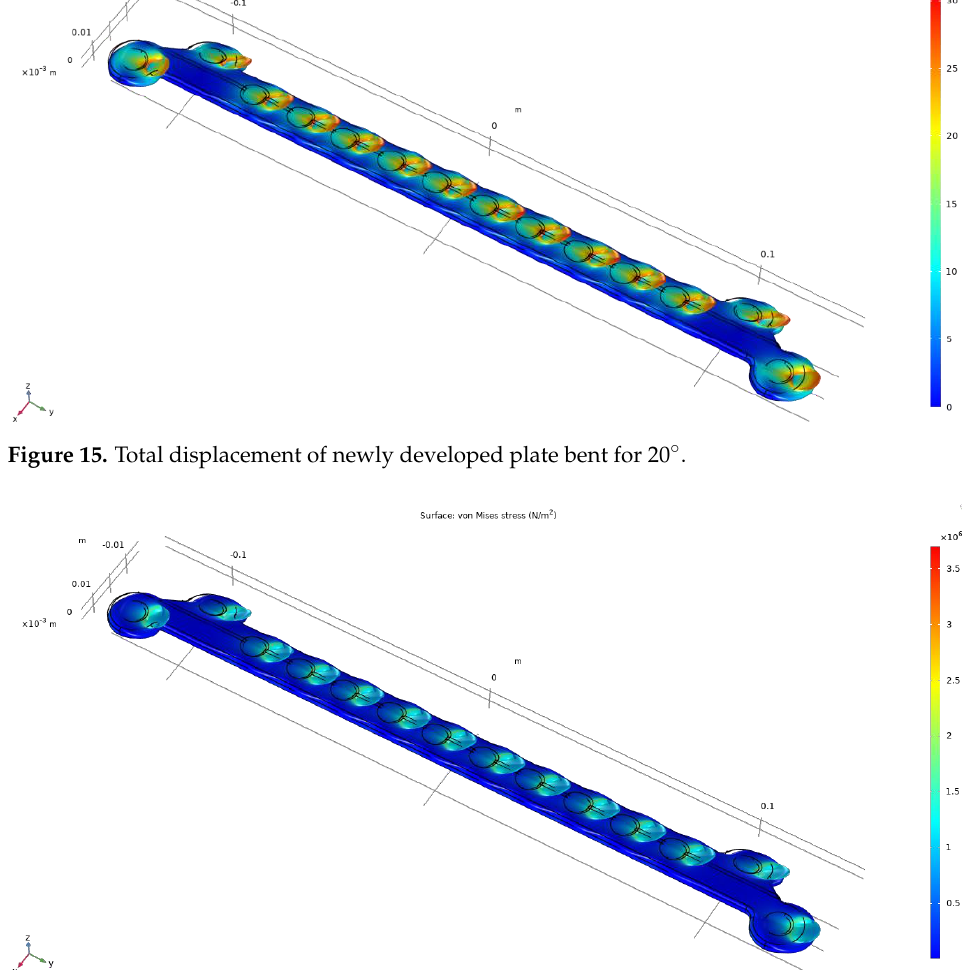
Figure 16. Von Mises stress of newly developed plate bent for 20°.